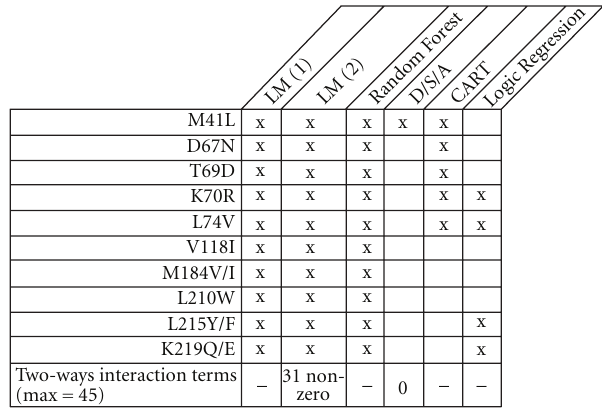
Figure 1: Selected mutations for each model on the complete Jaguar data Trial.